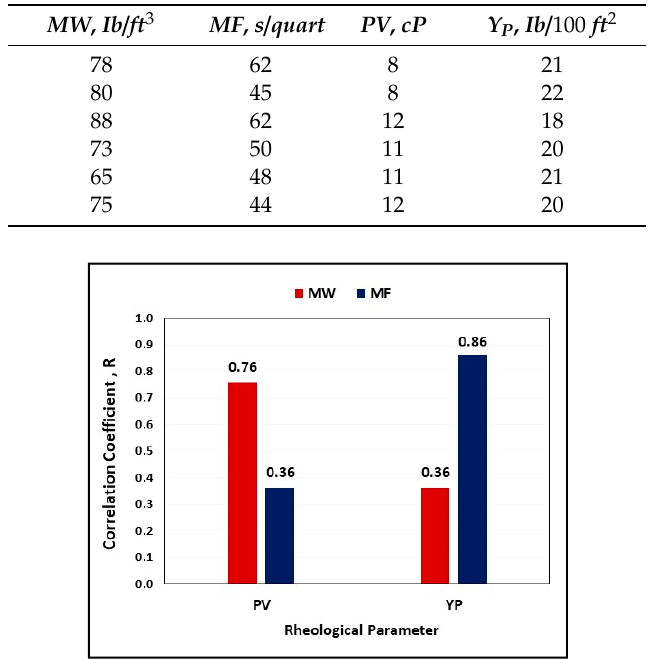
Table 1. A typical sample of the CaCl 2 brine-based drilling fluid collected data.